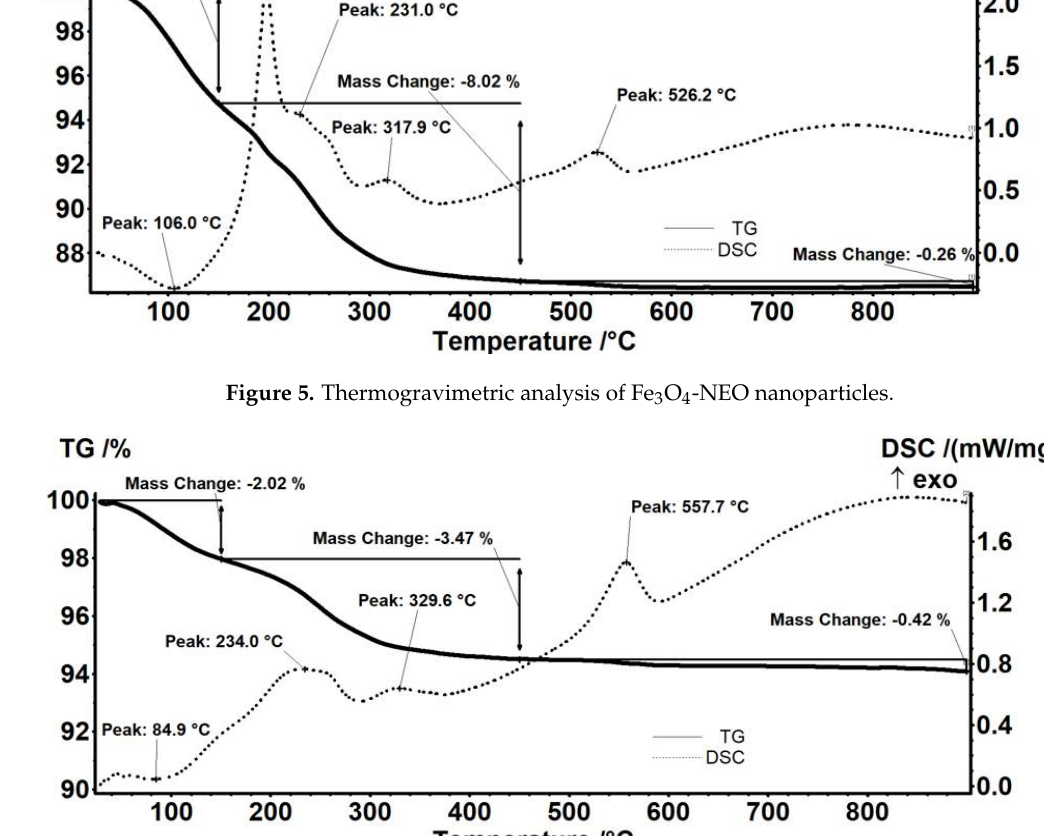
Table 1. Thermal analysis